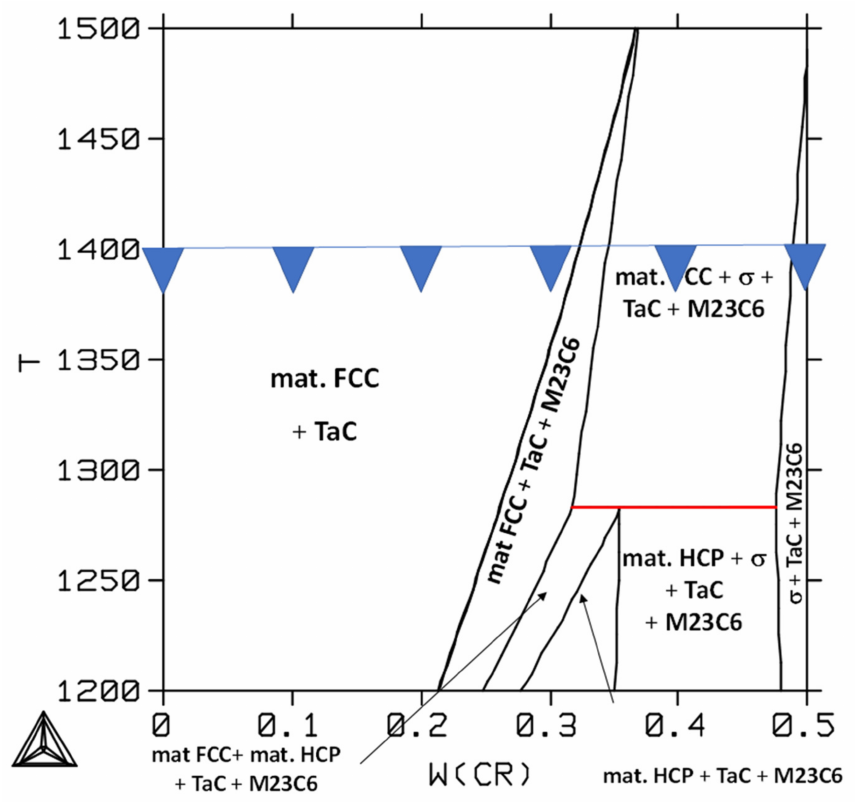
Figure 11. Medium temperature part of a (0.4wt%C, 6wt.%Ta) isopleth, computed with Thermo-Calc (the position of the six alloys at the aging treatment temperature are materialized by blue